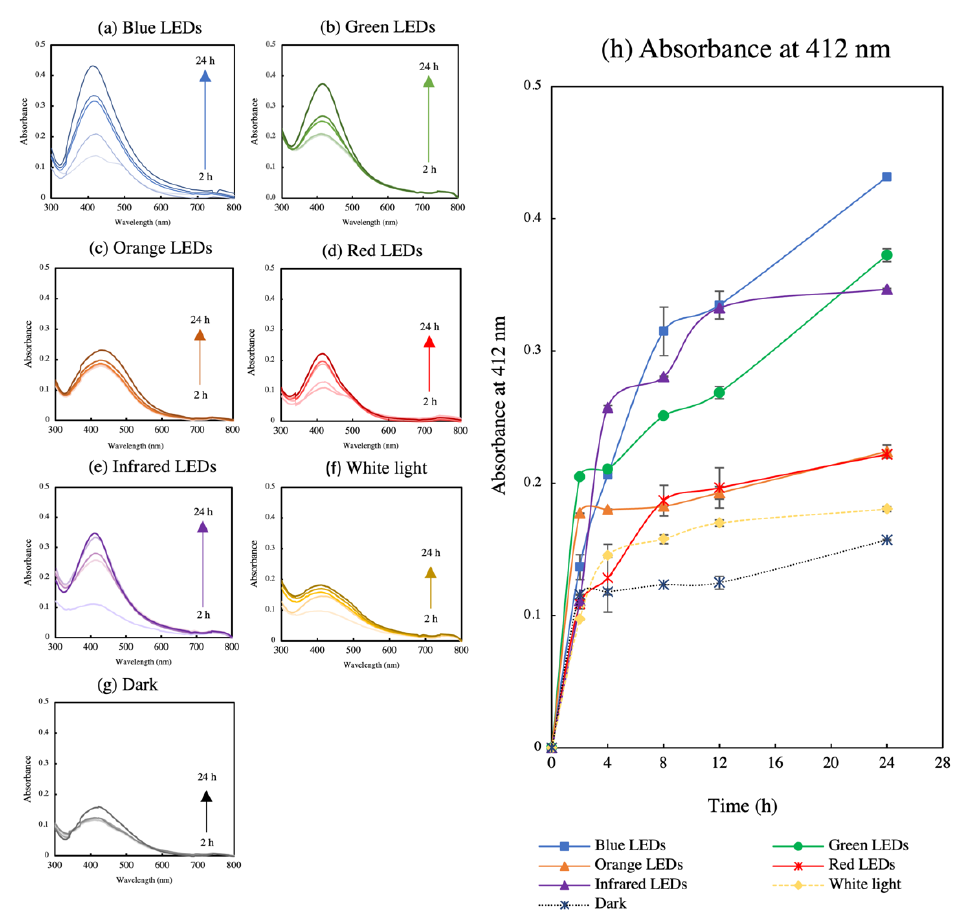
Figure 2. ( a – g ) UV–Vis spectrum of AgNPs obtained by T. purpurogenus extracellular pigment- mediated biosynthesis following exposure to lights at different wavelengths and ( h ) their absorbance at 412 nm for 24 h. The error bars indicate standard error (n = 3). Table 1. The maximum wavelength ( 𝜆 max ) and maximum absorbance ( A max ) after 24 h during T. purpurogenus extracellular-pigment-mediated AgNPs biosynthesis by light exposure at different wavelengths.